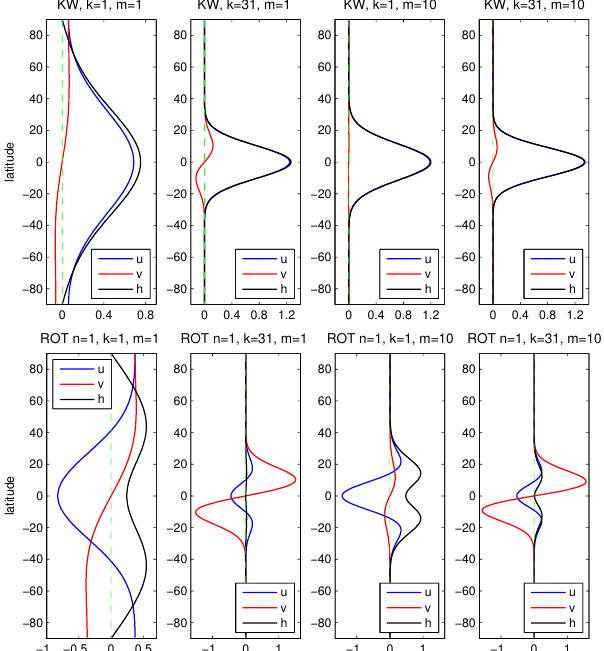
Figure 5. Meridional structure of the Hough harmonics for (top) Kelvin mode and (bottom) n = 1 balanced mode. The four pan- els for each mode correspond to various combinations of the zonal wave number k and vertical mode m , as defined in each panels’